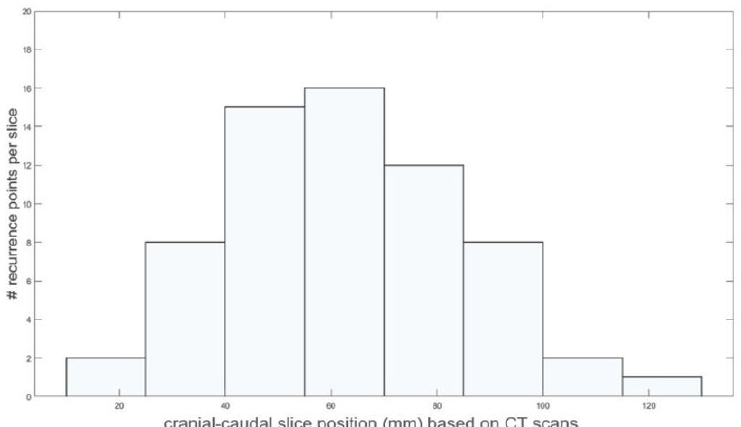
Figure 3. A histogram of the distribution number of recurrence points according to their position along the cranio-caudal direction (in mm) reported on the representative patient shown in Figure